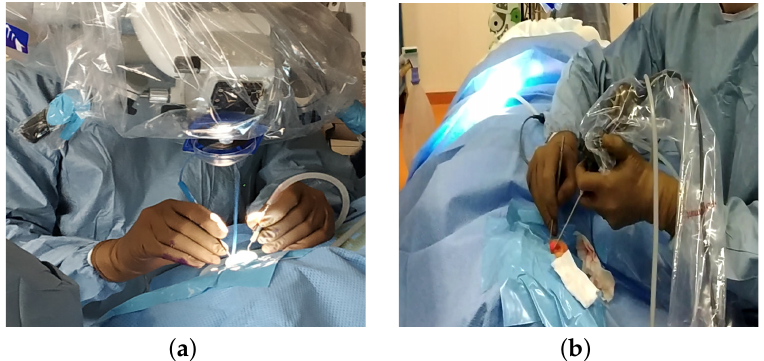
Figure 1. Comparison of the number of instruments that can be used simultaneously under the microscope and the endoscope. ( a ) Surgery under a microscope allowing for the use of both hands to operate. ( b ) Surgery under endoscopy, leaving only one hand for the operator to hold an instrument or